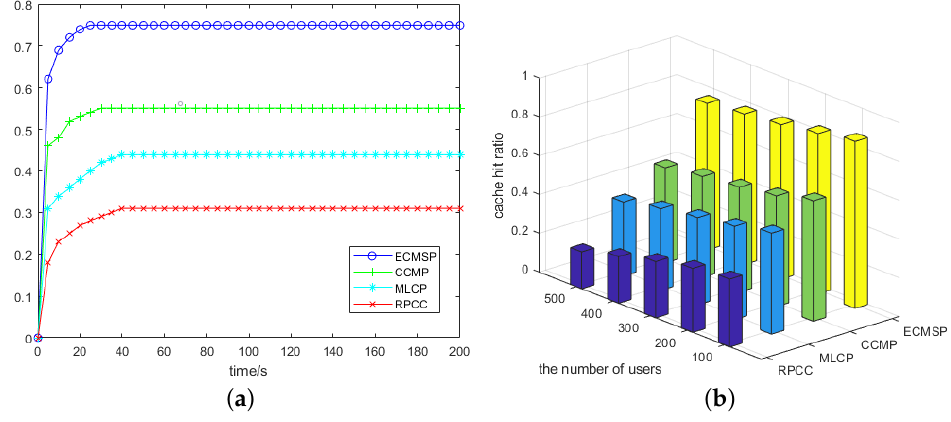
Figure 8. Comparison of cache hit ratio performance of four caching schemes: ( a ) cache hit ratio with the simulation time; ( b ) cache hit ratio with the number of mobile